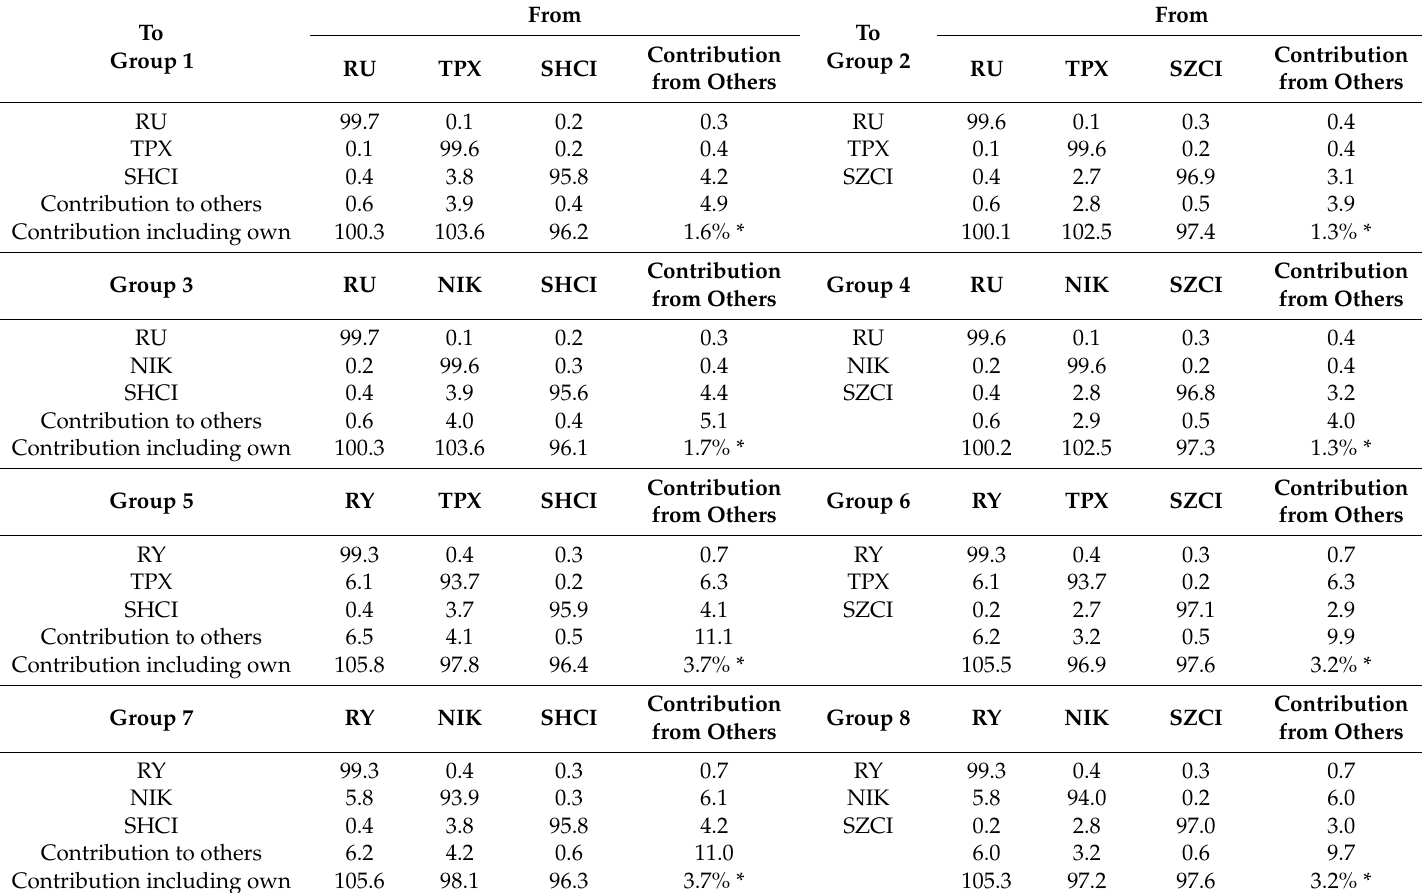
Table 8. Spillover Table on return by